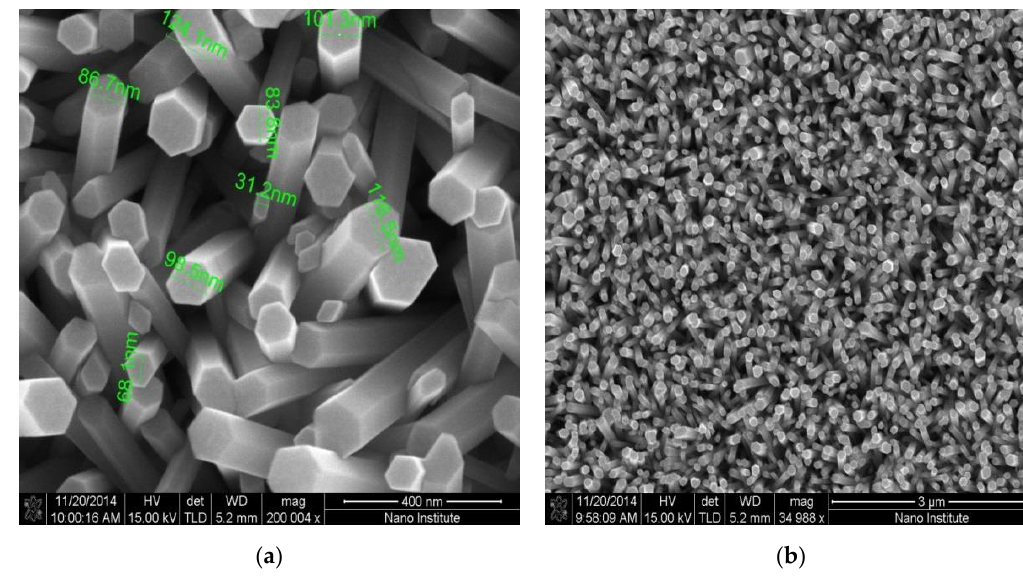
Figure 2. ( a ) SEM images of the directly grown ZnO NRs on Si/SiO 2 /Au at focusing area 400 nm and magnification 200,004 ×. ( b ) SEM image of the directly as-grown ZnO NRs on Si/SiO 2 /Au at focusing magnification 200,004 × . ( b ) SEM image of the directly as-grown ZnO NRs on Si/SiO 2 /Au at focusing area 3 µm and magnification 34,988 ×. area 3 µ m and magnification 34,988 ×